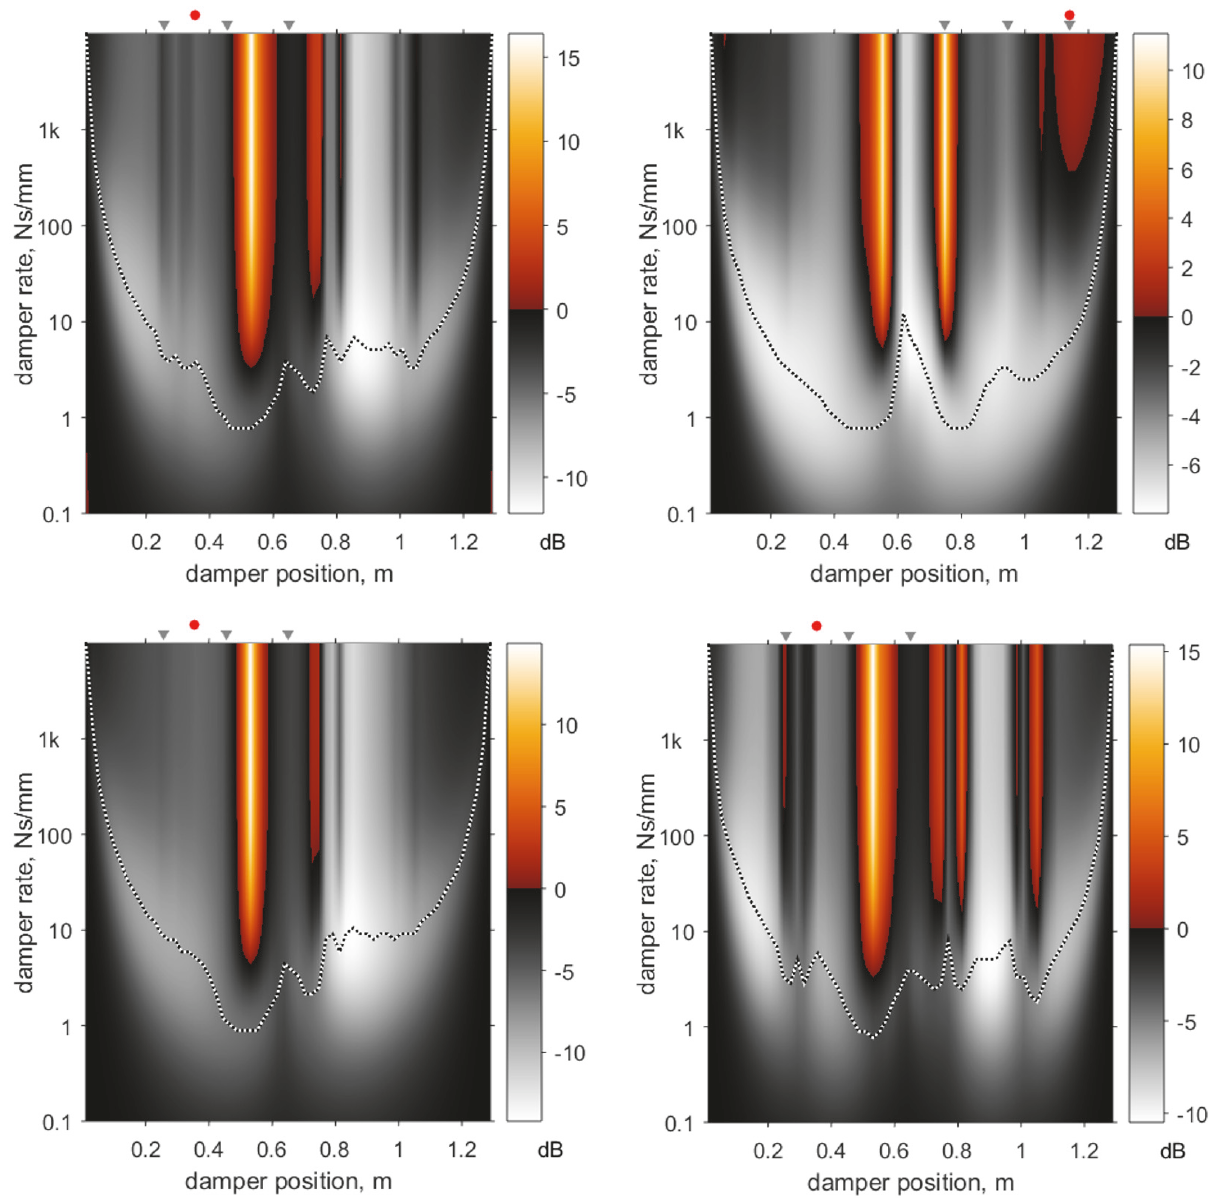
Figure 10: Kinetic energy level change of receiver beam by a passive damper. Excitation: top: ∝ √𝑓 RMS spectrum; bottom left: flat spectrum; bottom right: ∝ 𝑓 spectrum. Dotted line: damper rate giving best energy